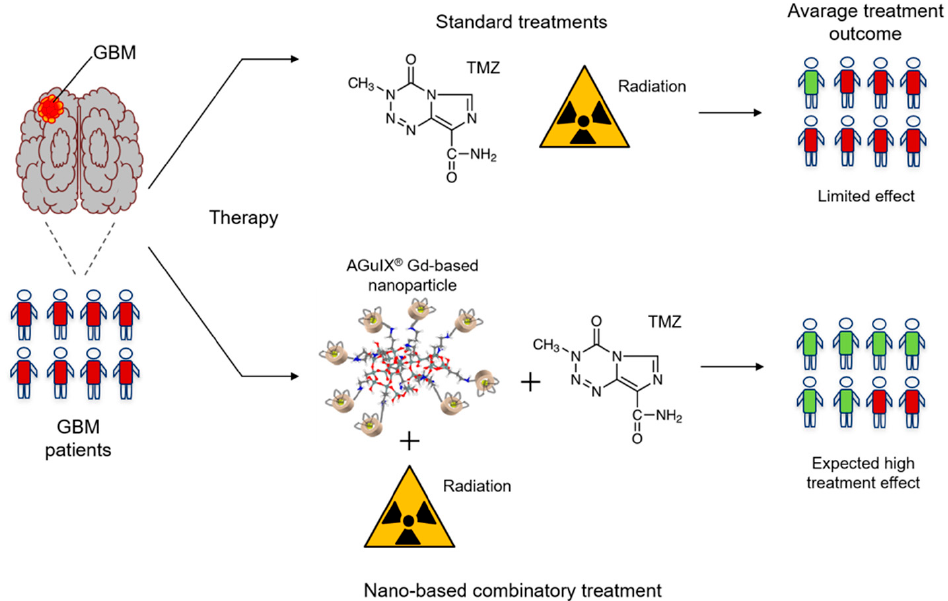
Figure 5. Schematic representation of the effects of AGuIX-based treatment. Patients treated simultane- ously with AGuIX, TMZ and radiation are expected to do better than patients only administered with TMZ and radiation. GBM—glioblastoma; TMZ—temozolomide; AguIX—Gd-based nanopar- ticle.